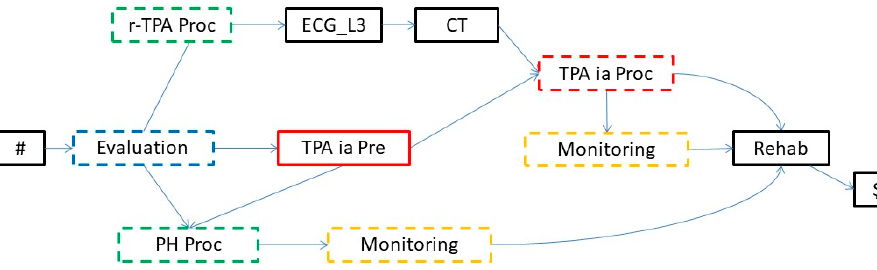
Figure 11. Process model abstracted at level 2 through the solution in Figure 9c.